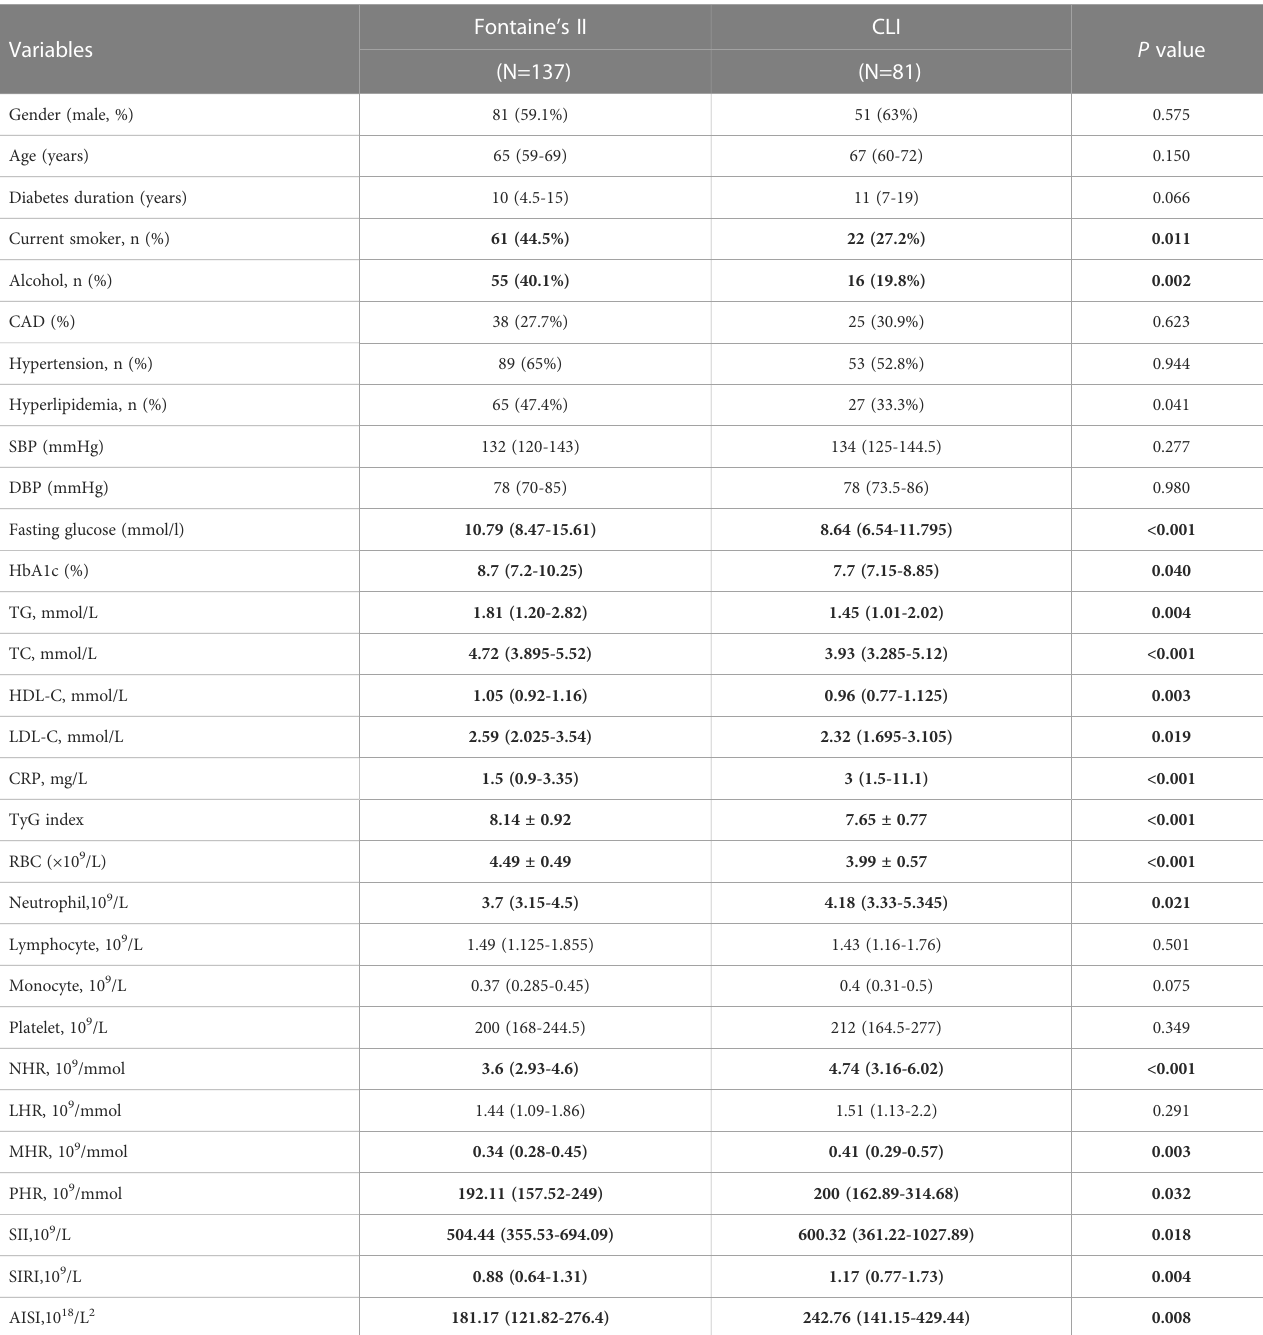
TABLE 3 Subgroup analysis of the clinical characteristics based on the Fontaine classi fi cation in patients with PAD.